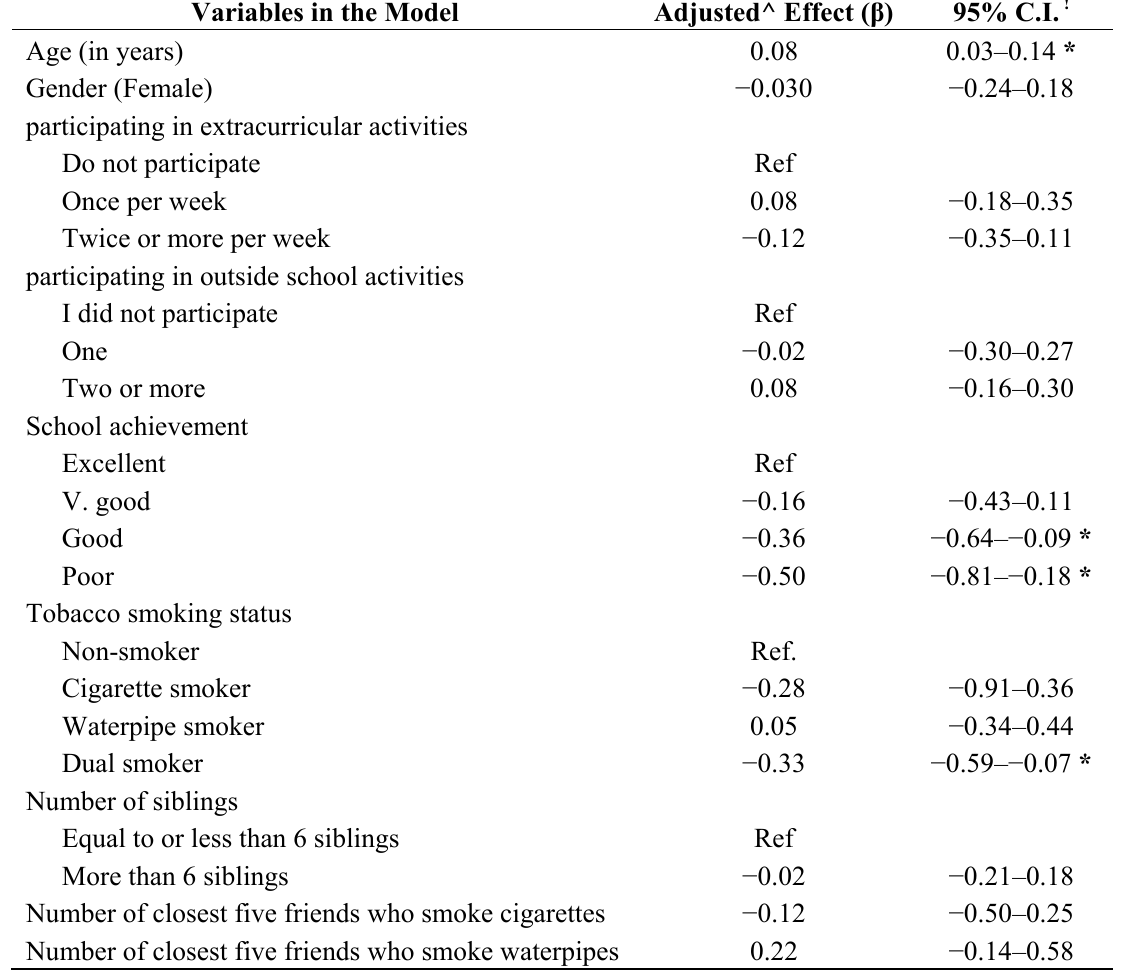
Table 6. Adjusted effect of tobacco smoking status on perceived health status (linear model) **